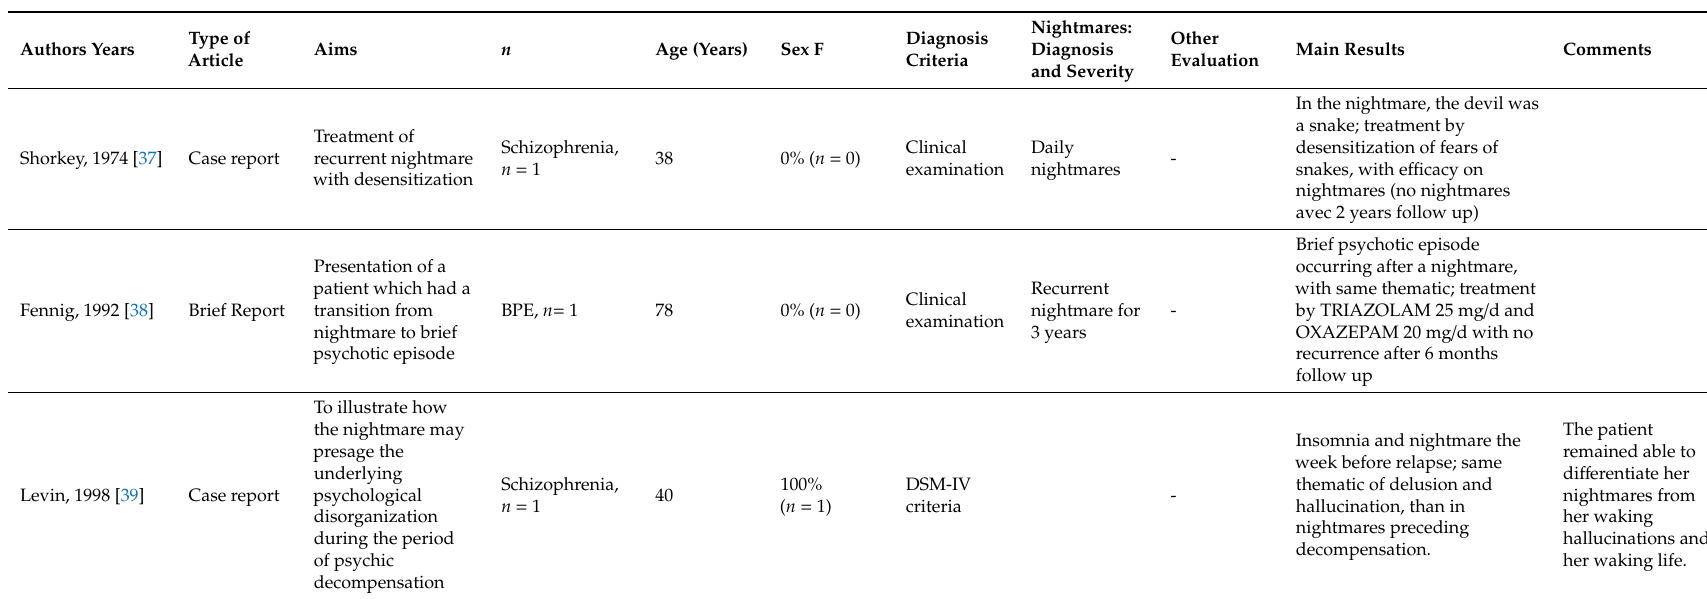
Table 2. Psychotic Disorders and